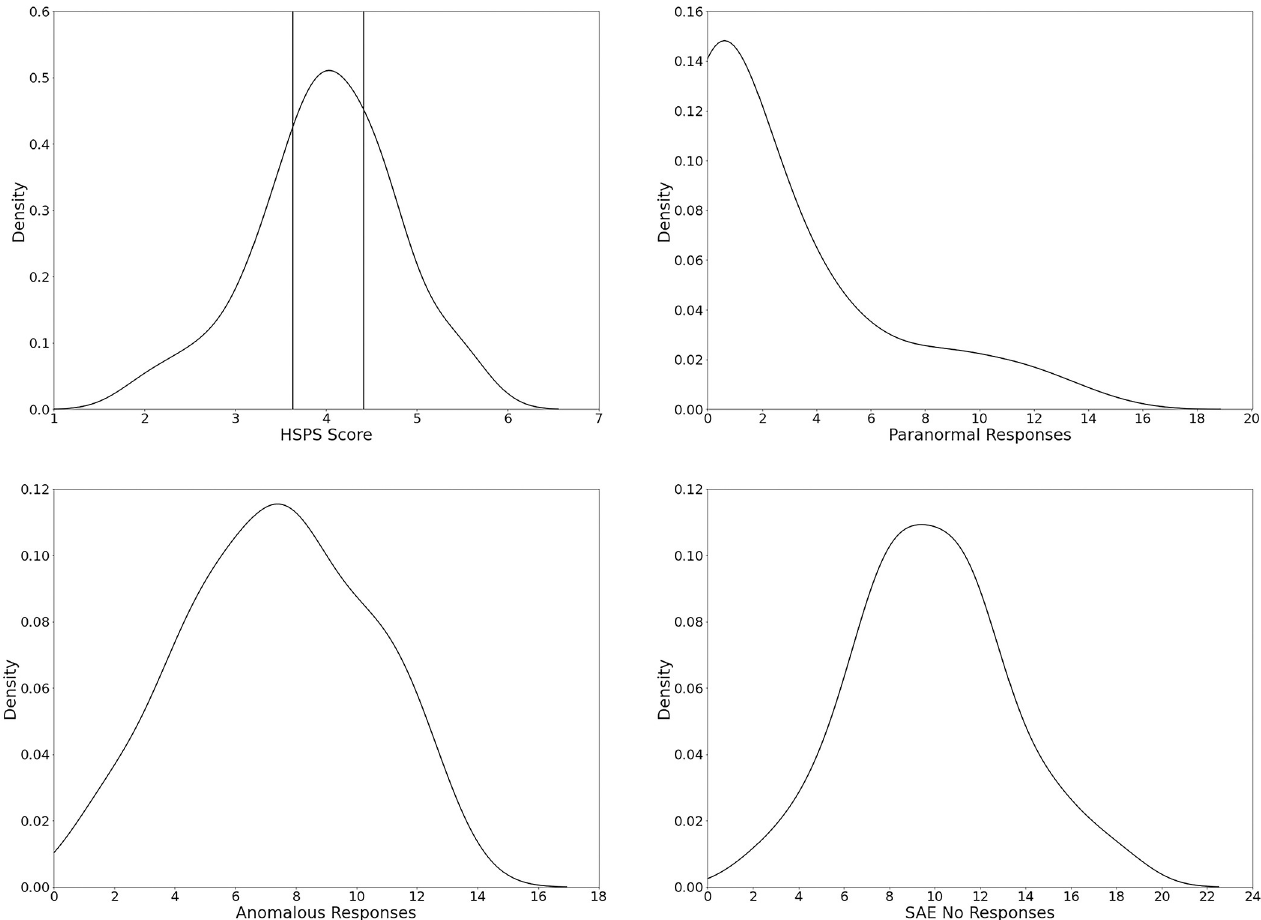
Fig 1. Density distribution of mean HSPS scores, total Paranormal Responses, Anomalous Responses, and SAE No Responses. For HSPS score, lines represent cut-off points for SPS groups as according to Lionetti et al [48]. The first line is the cut-off between the low SPS group (29.5% of the sample) and medium group (HSPS score = 3.63) and the second line for medium and high SPS group (31.1% of the sample) (HSPS score = 4.41). Density distributions for the subscales of the HSPS can be found in the S1 Fig.